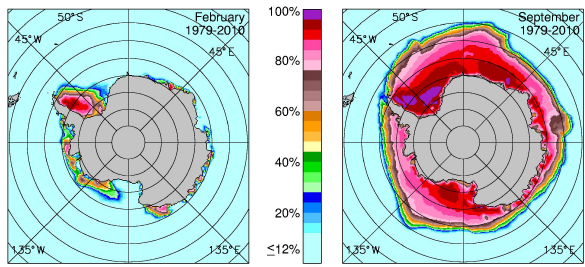
Fig. 1. Maps of Southern Hemisphere February and September sea ice concentrations, averaged over the years 1979–2010, as derived from SMMR, SSMI, and SSMIS satellite